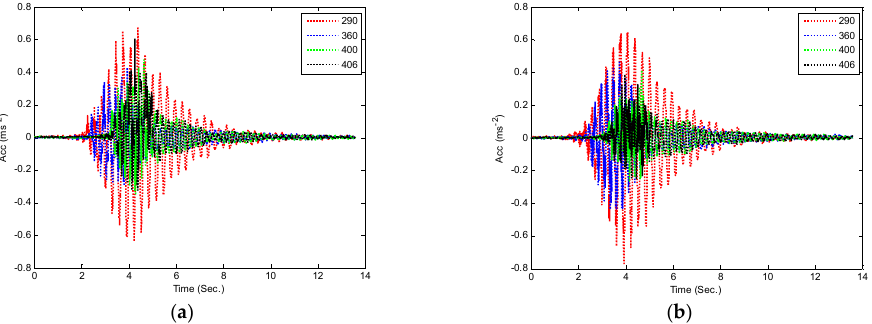
Figure 5. Vertical acceleration time histories of the passage and opposite mid span girder point. ( a ) passage response of mid span point; ( b ) opposite response of mid span point.